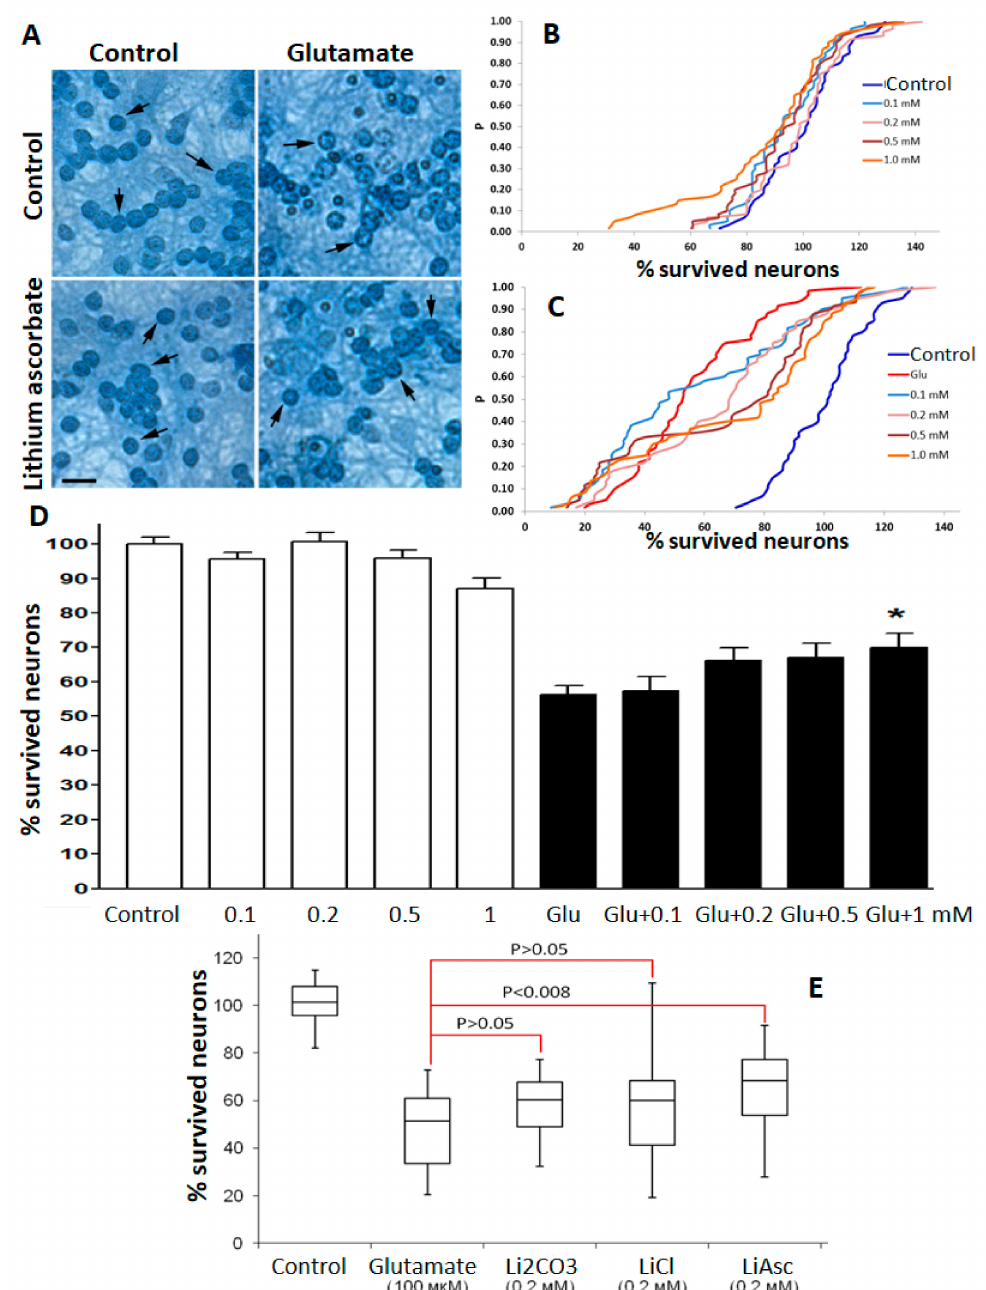
Figure 1. Results of neurocytological studies of lithium salts. ( A ) Representative photos of cultures of cerebellar granular neurons (indicated by arrows). Trypan blue staining of fixed cultures. Scale 1:0.000015. ( B ) Empirical distribution functions (e.d.f.) of the survival rate of neurons without the addition of glutamate (blank experiment); ( C ) E.d.f. of CGN survival under conditions of glutamate stress (100 µ M glutamate). ( D ) Evaluation of the neuroprotective effect of lithium ascorbate according to the ANOVA test. White bars—lithium ascorbate (0.1–1.0 mM) in the absence of glutamate, black bars—at the same concentrations in the presence of 100 µ M glutamate (Glu). K—control. For each column, 30 fields of view were calculated. *— p <0.01 compared with glutamate without the addition of drugs. ( E ) Comparison of the neuroprotective efficacy of various lithium salts (at a concentration of 0.2 mM) under conditions of moderate glutamate stress (100 µ M glutamate, 50% neurons survived). Li 2 CO 3 , lithium carbonate; LiCl, lithium chloride; LiAsc, lithium ascorbate. P, statistical significance in accordance with the Kolmogorov–Smirnov